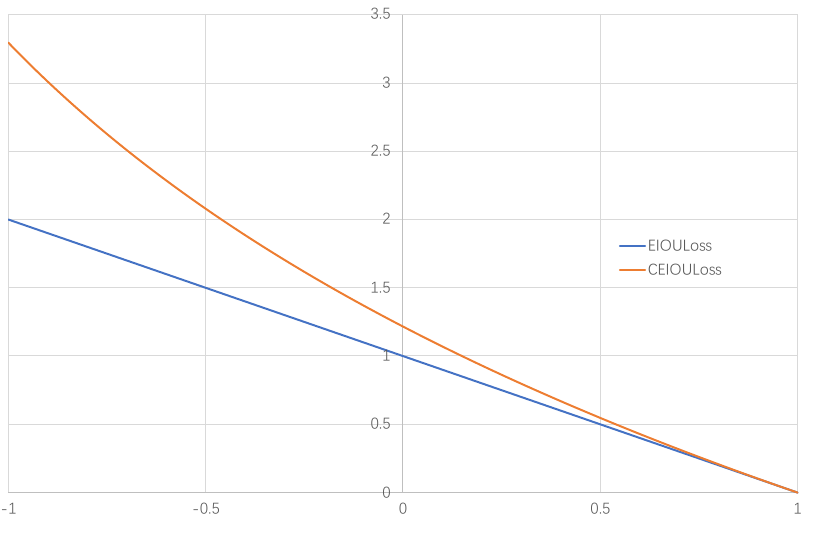
Figure 6. Comparison of 𝐶𝐸𝐼𝑂𝑈 𝑙𝑜𝑠𝑠 and 𝐸𝐼𝑂𝑈 𝑙𝑜𝑠𝑠 .